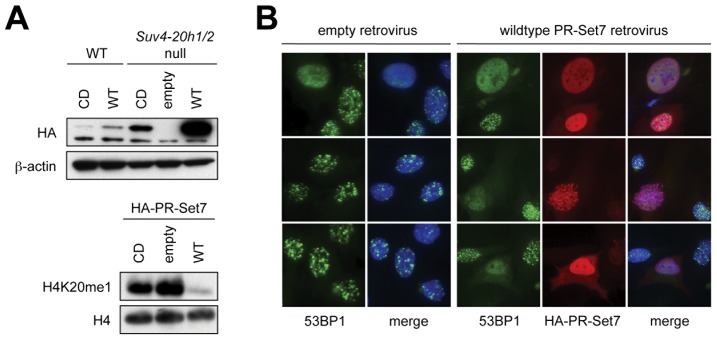
Perturbed 53BP1 focus formation in cells depleted of H4K20me1.
A) Top: Immunoblot for HA-PR-Set7 proteins (WT = wild type, CD = catalytically dead) and β-actin loading control in wild type and Suv4-20h1/2 null cells. Bottom: Immunoblot for H4K20me1 and H4 loading control in Suv4-20h1/2 null cells infected with empty, PR-Set7 WT and PR-Set7 CD retrovirus. B) 53BP1 focus formation and HA immunofluorescence staining in Suv4-20h1/2 null cells expressing empty or HA-PR-Set7 WT retrovirus, 30 minutes after 3 Gy IR treatment.